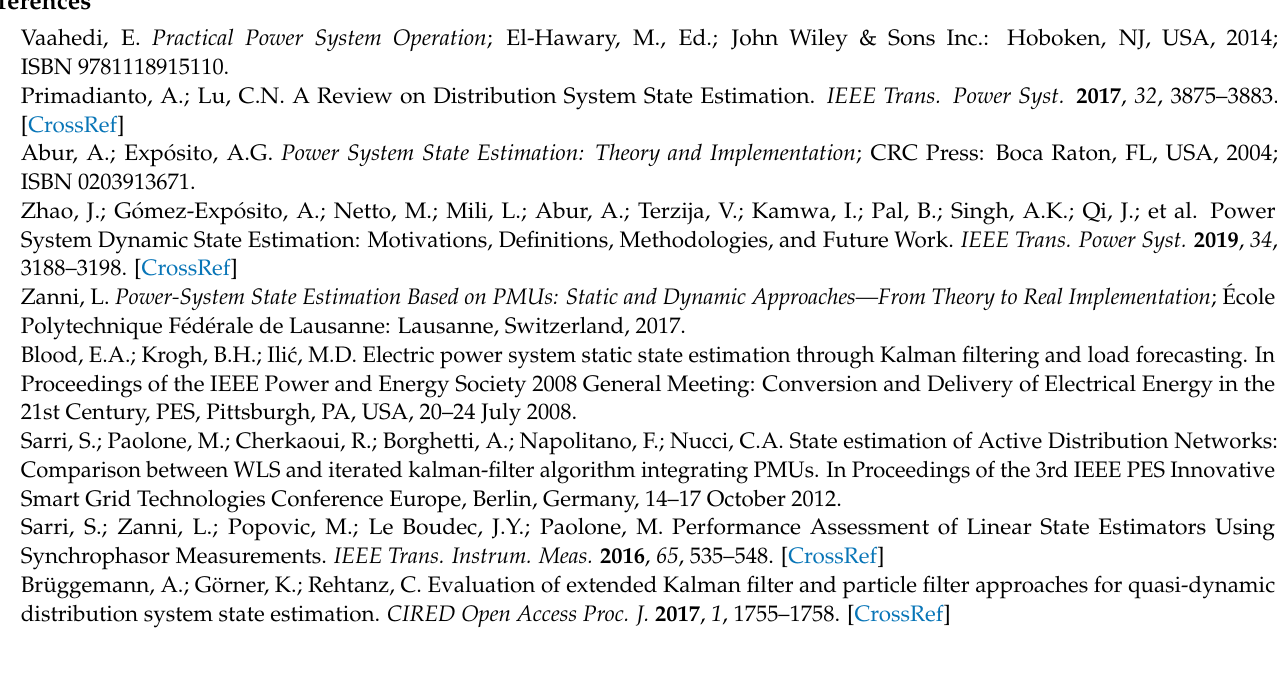
Estimation and prediction error covariance matrices at κ -instant Average absolute deviation 1 Bold letters represent either vectors or